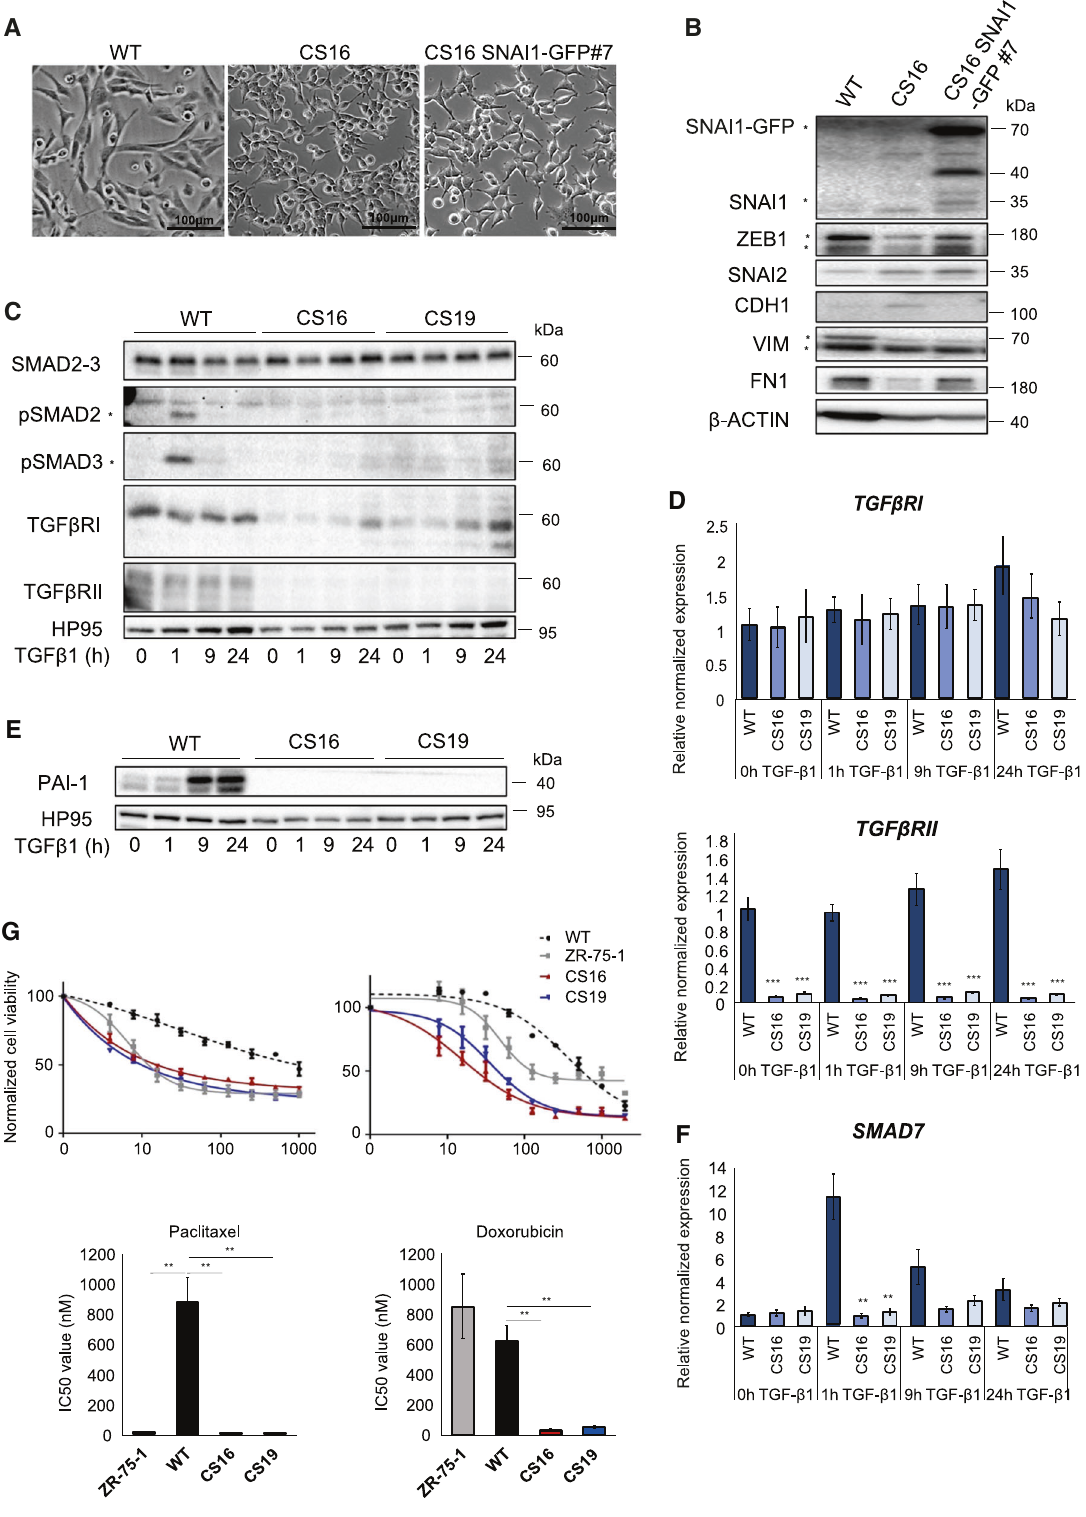
cells (Fig. 2F). WT mesenchymal cells were characterized by complete absence of such junctions, while ZR-75-1 luminal BRCA cells were characterized by complete junctions (Fig. 2F). Further- more, SNAI1 -KO cells exhibited substantial networks of cortical F-actin assembly, characteristic of epithelial cells, in contrast to the